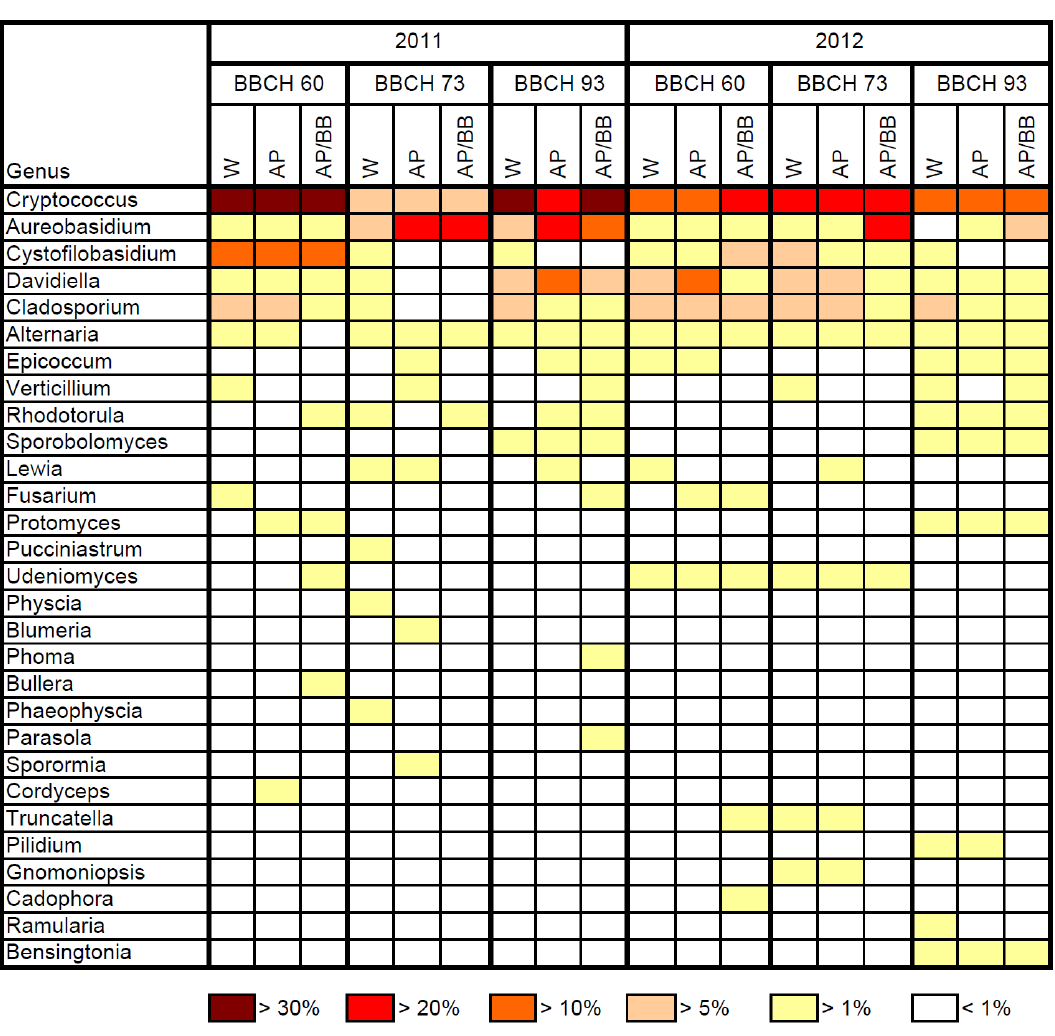
Figure 3. Most abundant fungal genera in the strawberry phyllosphere at three distinct phenological stages (BBCH 60, BBCH 73, and BBCH 93) during two subsequent years (2011, 2012) as influenced by treatments with Aureobasidium pullulans as a single strain treatment (AP) or co-inoculated with Beauveria bassiana (AP/BB) and as determined by 454 pyrosequencing. The control (W) was treated with water from a lotic reservoir. Results from all treatments at BBCH 60 (prior to BCA applications) represent the resident fungal community. The color legend refers to the relative abundance (% of total sequences) of fungal